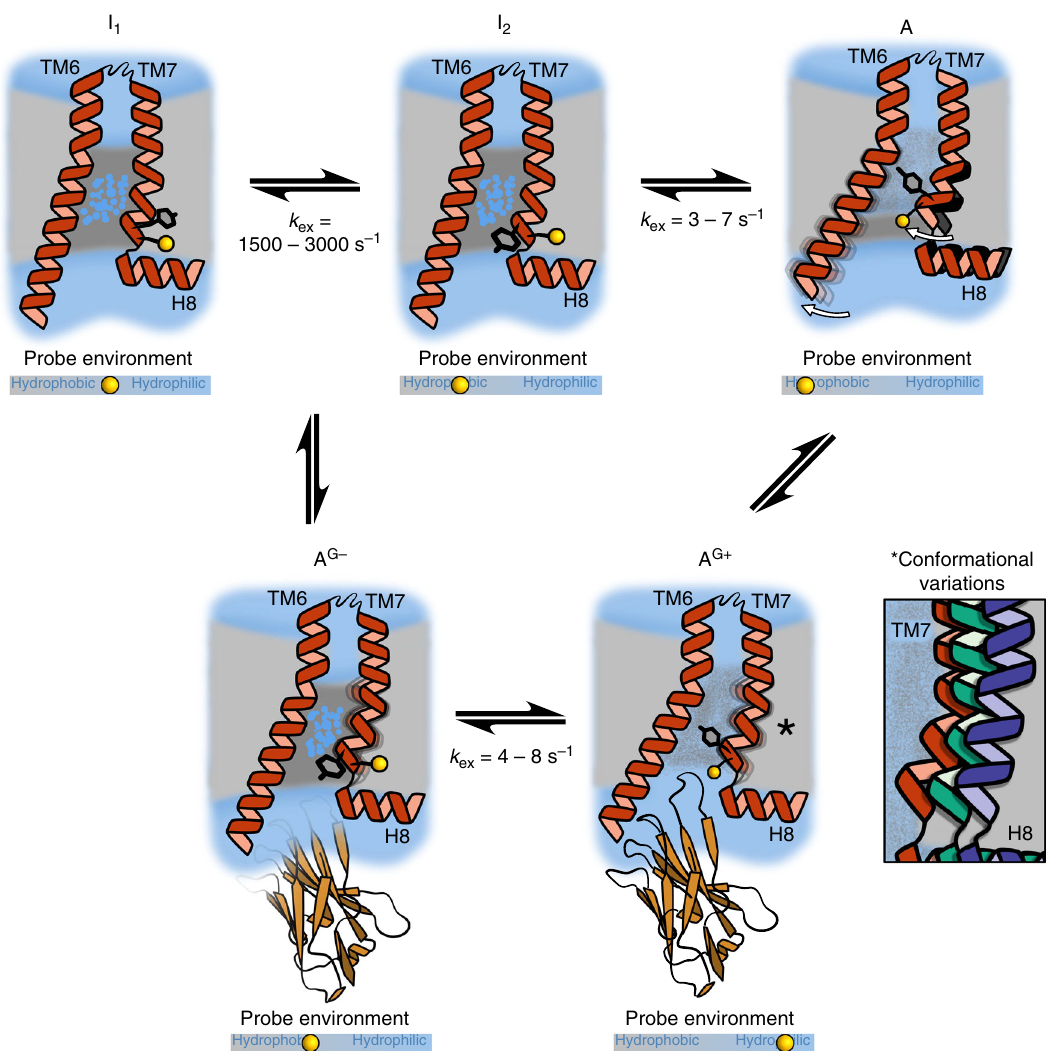
Fig. 5 Schematic overview of β 1 AR ligand activation and ternary complex formation. Cartoon cross sections spanned by TM6, TM7 and H8 with the TM7 TET C344 7.54 probes shown as yellow spheres, adjacent to Y343 7.53 of the NPxxY motif. The receptor exists in an equilibrium of inactive states (I 1,2 ) and a pre-active state (A), with the latter populated in growing amounts with increasing ef fi cacy of the bound ligand. Nanobody Nb6B9 addition leads to the formation of a fully active ternary complex (A G + ) in amounts proportional to the ligand ef fi cacy. Nanobody binding also occurs with the inactive form of the receptor, resulting in the formation of (A G − ). The latter can be considered as a pre-coupled inactive form, with inactive and active ternary complexes in slow exchange with each other. The binding interface in the (A G − ) complex is shown faded, emphasising that Nb6B9 has not yet fully engaged the epitope characteristic of the active receptor state. The (I 1 ) ⇌ (I 2 ) interchange takes place on a μ s-to-ms timescale, while the (I 2 ) ⇌ (A) interchange as well as the (A G − ) ⇌ (A G + ) exchange occurs on a slower sub-second timescale. Exchange rates, where measured, are indicated below the equilibrium arrows. In the ternary state (A G + ) the cytoplasmic region of TM6 is rigid while TM7 remains dynamic on the μ s-to-ms timescale, implied by TM7 showing partly blurred. In (A G + ) the conformation of TM7 in the vicinity of the NPxxY motif reveals agonist-dependent conformational differences, emphasised by TM7 showing in different colours in the enlarged region marked with (*). The grey slider below each receptor cartoon approximates the relative hydrophobic/hydrophilic extent of the TM7 19 F NMR probe surrounding in that particular state. Lipid bilayer hydrophobic regions are shown in light grey. Dark grey areas indicate transmembrane regions of the receptor with residues rich in hydrophobic side chains. These form hydrophobic gates above and below the NPxxY region (e.g. in I 1 and I 2 ) that shield the receptor interior against bulk water access. Blue dots on a grey background (e.g. in I 1 , I 2 and A G − ) indicate ordered internal water molecules, separated from the bulk water through the hydrophobic gates (dark grey). Conformational changes upon activation disrupt the two hydrophobic side chain layers, resulting in the gradual opening of a continuous internal water pathway with cytoplasmic in fl ux of bulk water, as indicated by the speckled grey/blue area between TM6 and TM7 in (A) and (A G + as it involves the rotation and inward shift of TM7 and depends on the outward movement of TM6 having already occurred.